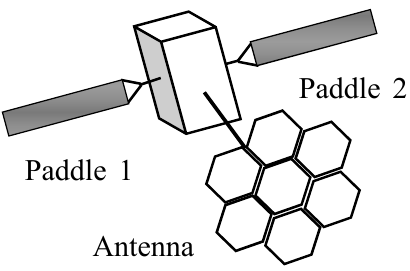
Figure 1. A satellite with flexible appendages.